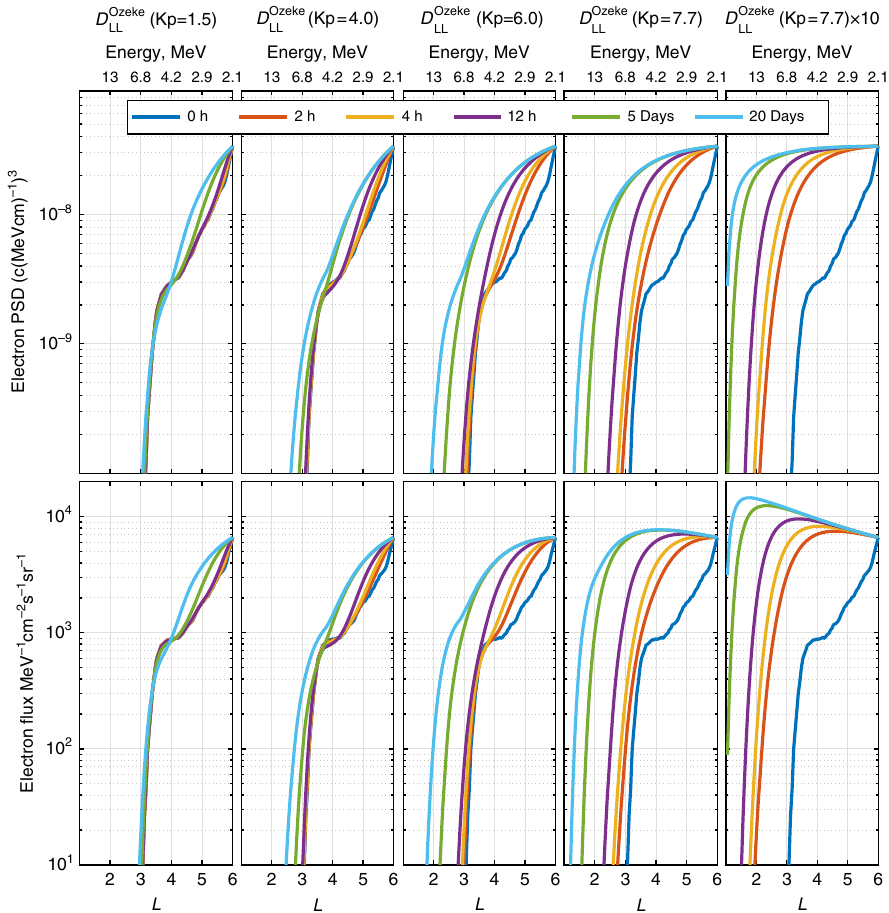
Fig. 4 Ultra-relativistic electron phase space density (PSD) (top row) and fl ux (bottom row) pro fi les as a function of L- shell (bottom axes) and energy (top axes) for 1500 MeV/G electrons. The different colored curves indicate the simulated electron fl ux and PSD at different times, with the initial PSD and fl ux at t = 0 being derived from the fl ux measured by Van Allen Probe A on 1 September 2012. The fl ux and PSD at the outer boundary of L = 6 is derived from the mean 2.1 MeV electron fl ux measured by Van Allen Probes A and B from 1 September to 31 May 2014. The radial diffusion coef fi cients are speci fi ed using D LL [Ozeke] at the fi xed Kp-values